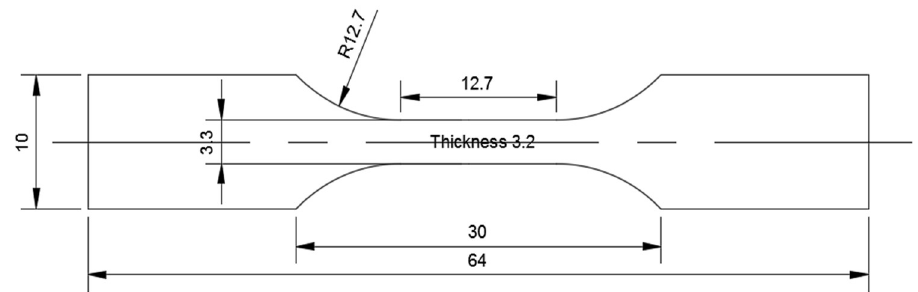
Figure 1. Detailed dimensions of tensile bar specimens produced for characterization in this study (unit in millimeters).